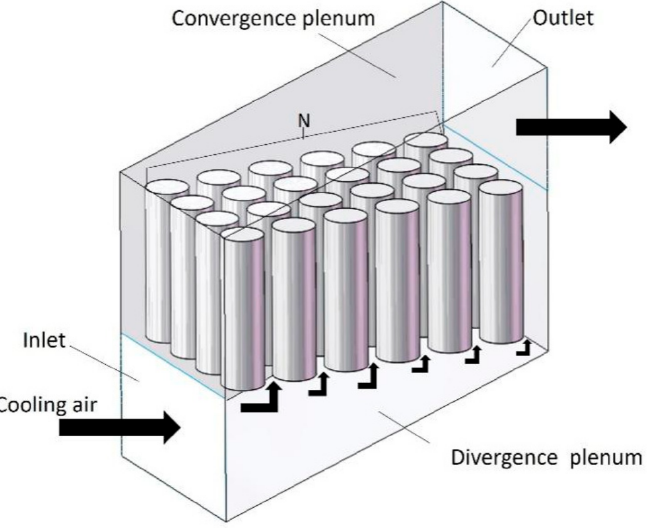
Figure 1. Three-dimension of the parallel air-cooled